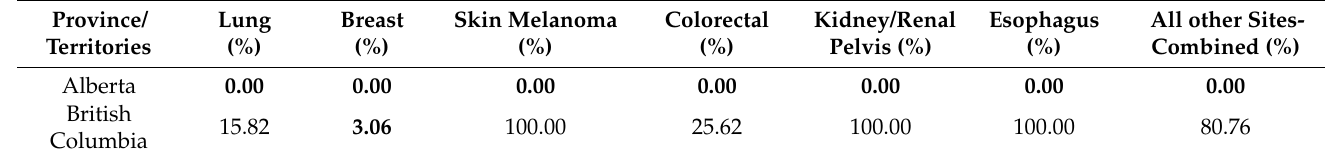
Table 2. Percentage of ‘unknown and not applicable data’ on brain metastases at diagnosis in Canada by province/territories by primary cancer sites